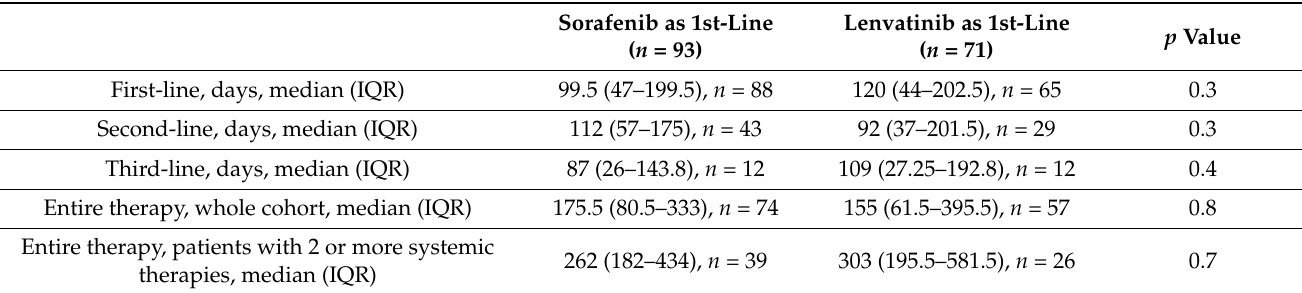
Table 3. Duration of sequential systemic therapies according to first-line